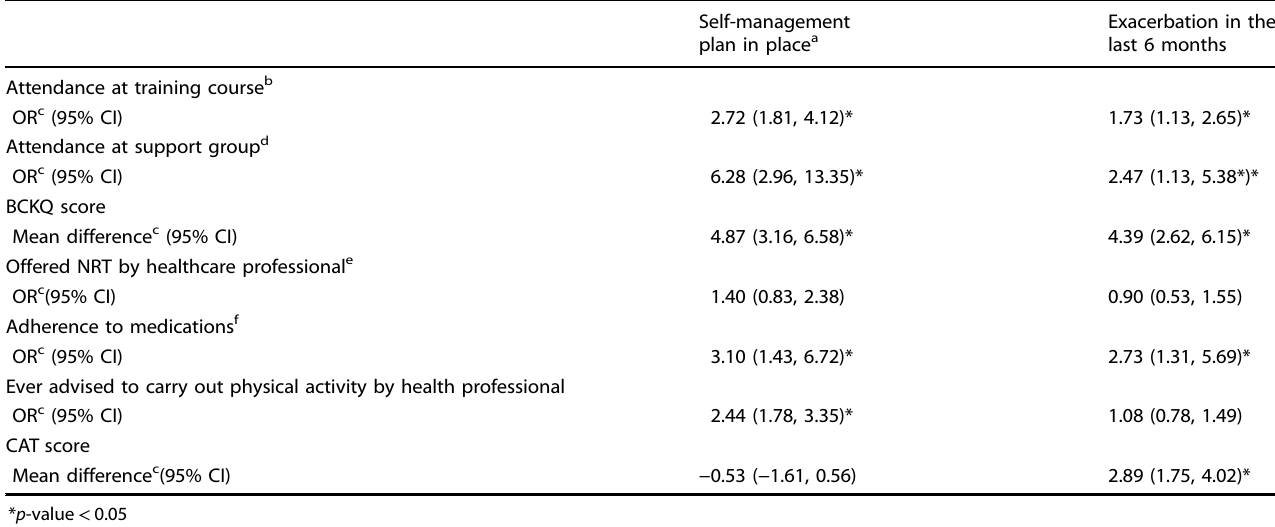
Table 6. Knowledge, behaviours and advice associated with having a self-management plan and report of recent